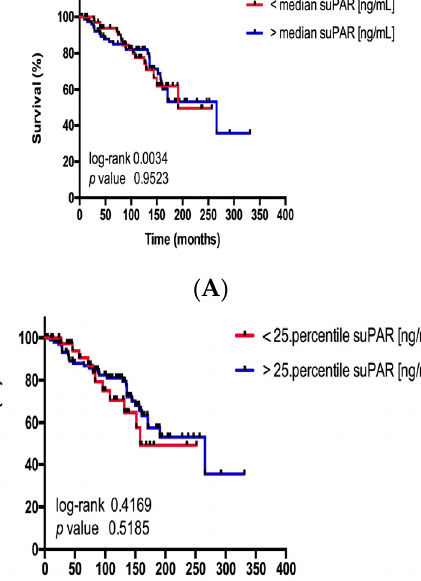
8 of 14 Figure 2. suPAR serum levels do not reflect tumor characteristics. Circulating levels of suPAR are unaltered between NET patients with ( A ) different tumor localization, ( B ) with lower or higher Ki-67 rates, ( C ) histological grade (Grade (G) 1 to 3), ( D ) functional or nonfunctional disease, ( E ) SSR positive or negative disease as well SSR positive or negative disease. Furthermore, analysis of different subgroups with. ( F ) different T-stages, ( G ) non-metastasized and metastasized patients, ( H ) lymph node metastases as well as ( I ) hepatic and ( J ) peritoneal carcinomatosis did not show any significant difference. ( K ) postoperative relapse status did not show any significant difference. Box plot are displayed, where the bold line indicates the median per group, the box represents 50% of the values. The horizontal lines show minimum and maximum values of calculated nonoutlier values. NET, neuroendocrine tumors; SSR, Somatostatin receptor. Circulating suPAR has recently been associated with chronic kidney disease and elevated suPAR serum levels were suggested to predict impaired renal function after cardiac surgery [26–28]. Hence, we evaluated if circulating levels of suPAR might be indicative for kidney injury in our cohort of patients. Interestingly, serum levels of suPAR were significantly higher in patients with elevated serum creatinine concentrations (Figure 3A) and both parameters demonstrated a significant correlation according to Spearman rank correlation analysis (Figure 3B). ( A ) ( B ) Figure 3. suPAR levels in NET are indicative for renal failure. ( A ) Serum levels of suPAR were significantly higher in patients with elevated serum creatinine. ( B ) Both parameters demonstrated a significant correlation according to spearman rank correlation analysis (Figure 3B). Box plot are displayed, where the bold line indicates the median per group, the box represents 50% of the values. The horizontal lines show minimum and maximum values of calculated nonoutlier values (**** p < 0.0001). 3.4. suPAR Serum Concentrations are not Associated with Overall Survival in Patients with NET A prognostic role of suPAR serum concentrations was recently suggested in patients with benign